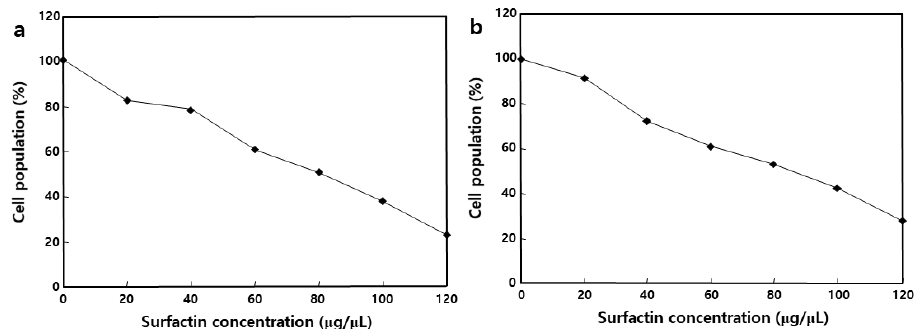
Figure 6. Cell population of human breast (MCF-7) and intestinal (Caco-2) cancer cell lines according to treatment of different surfactin concentrations: ( a ) mixture of five surfactin isoforms of cheonggukjang -treated MCF-7 cells; and ( b ) mixture of five surfactin isoforms of cheonggukjang -treated Caco-2 cells.